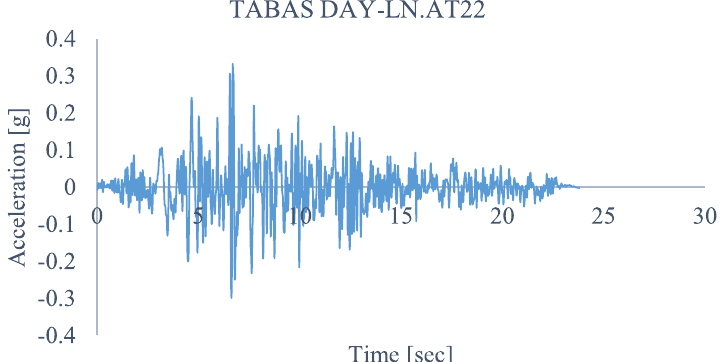
Fig. 8 The record of the horizontal component (DAY‑LN) of the Tabas earthquake